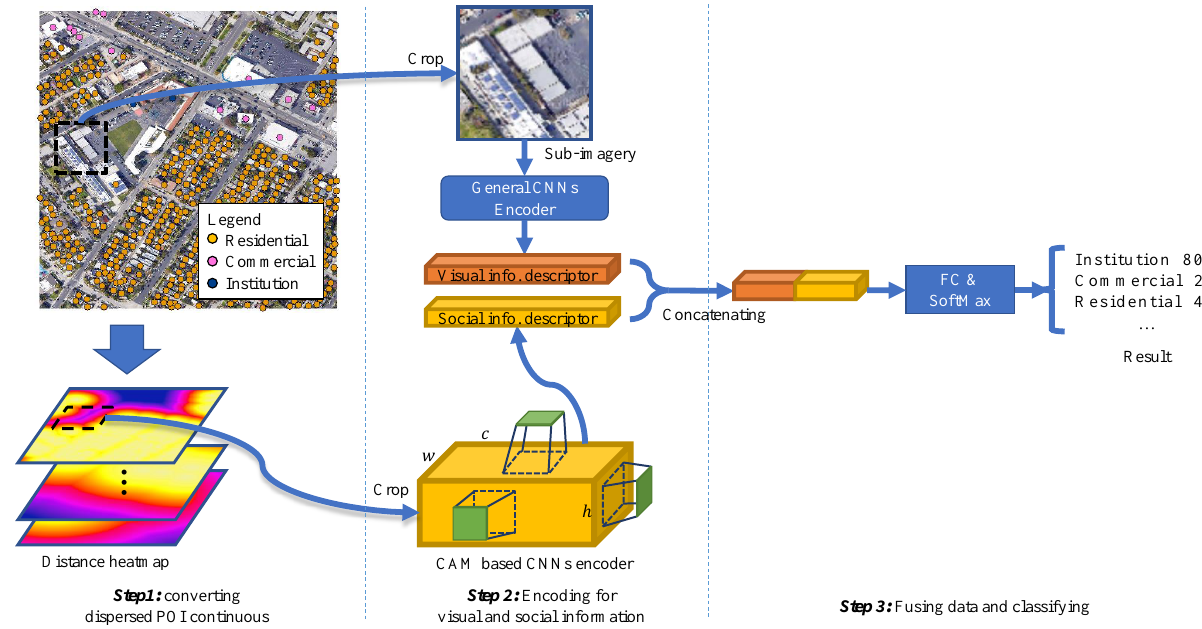
Figure 1. Flowchart of SIF-Net. There are three main steps. Step one, converting dispersed POI data continuous. Step two, crop POI and RSI data and encoding them. Step three, fusing two data by concatenating them and